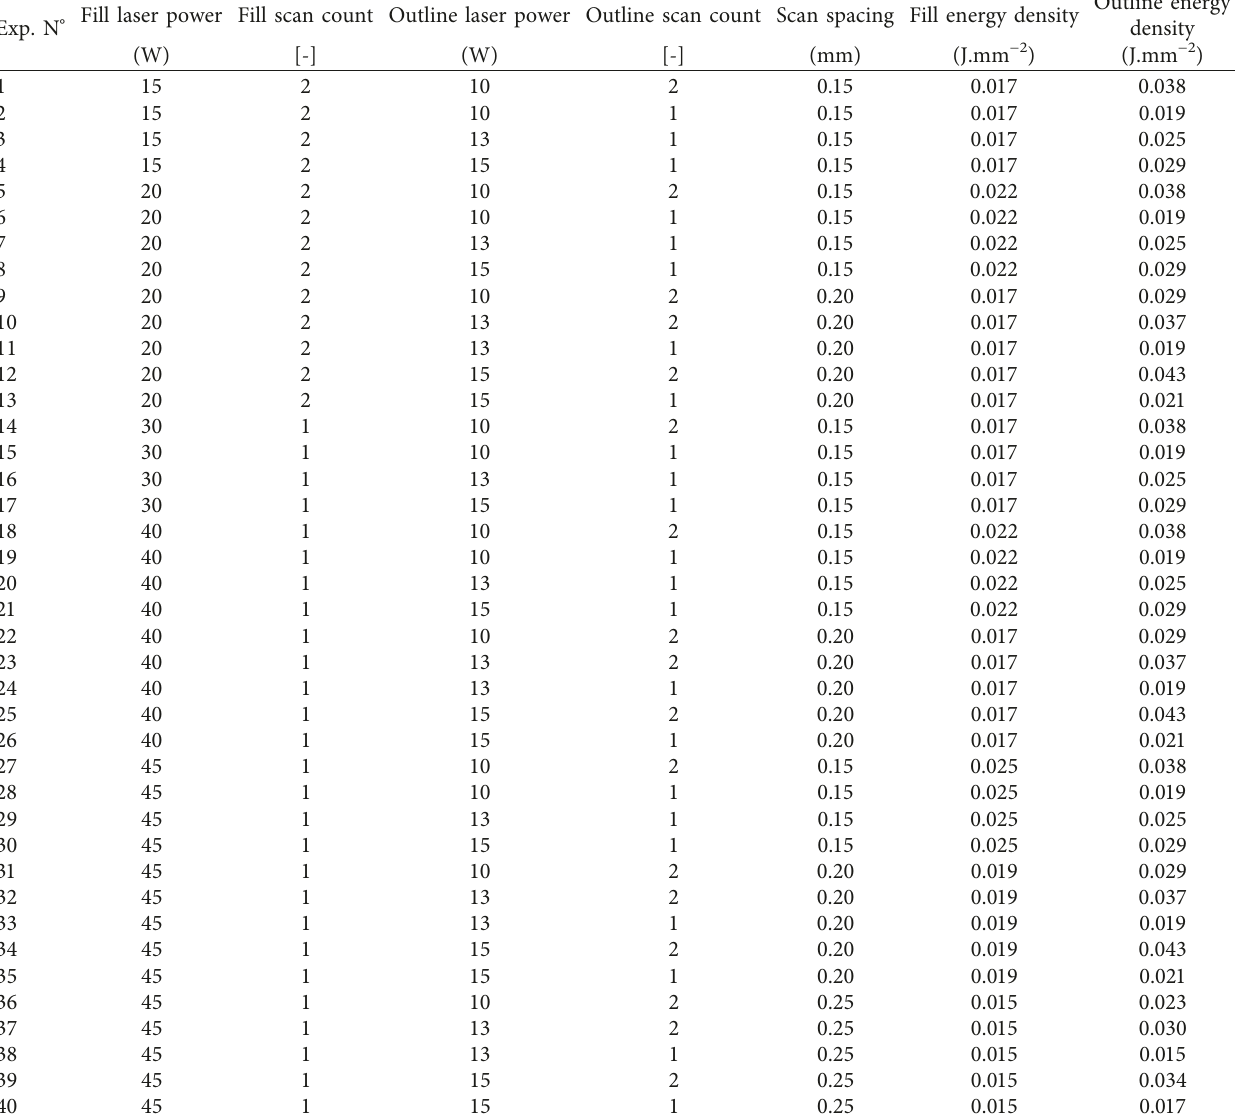
Table 2: Experimental design with variable values for Duraform